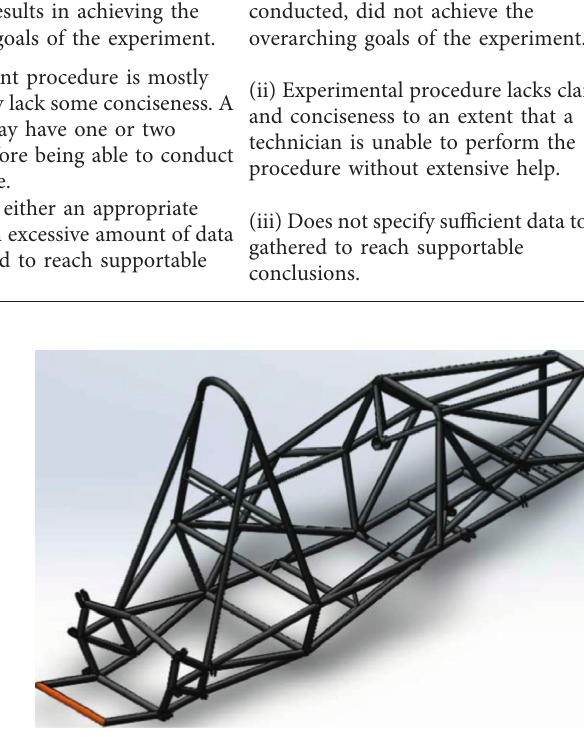
Figure 1: Frame from the previous FSAE